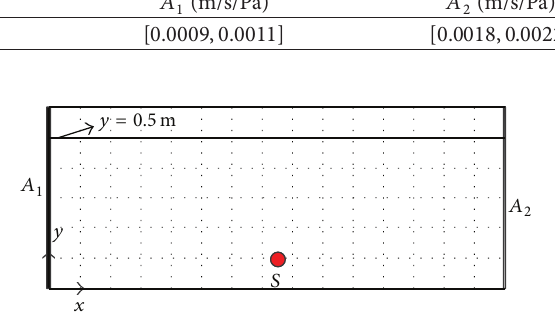
Figure 1: Finite element mesh of the 2D rectangular